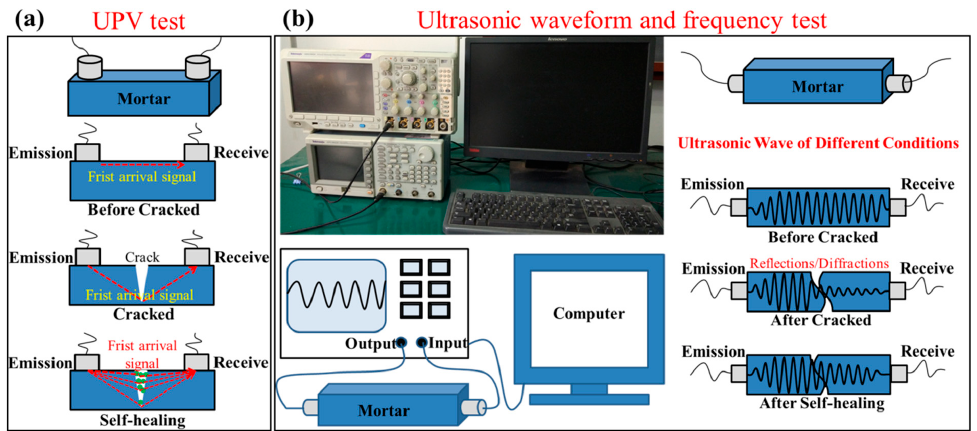
Figure 2. Ultrasonic test device and schematic diagram. ( a : the schematic diagram of the UPV test, b : the ultrasonic waveform and frequency test device and the typical ultrasonic